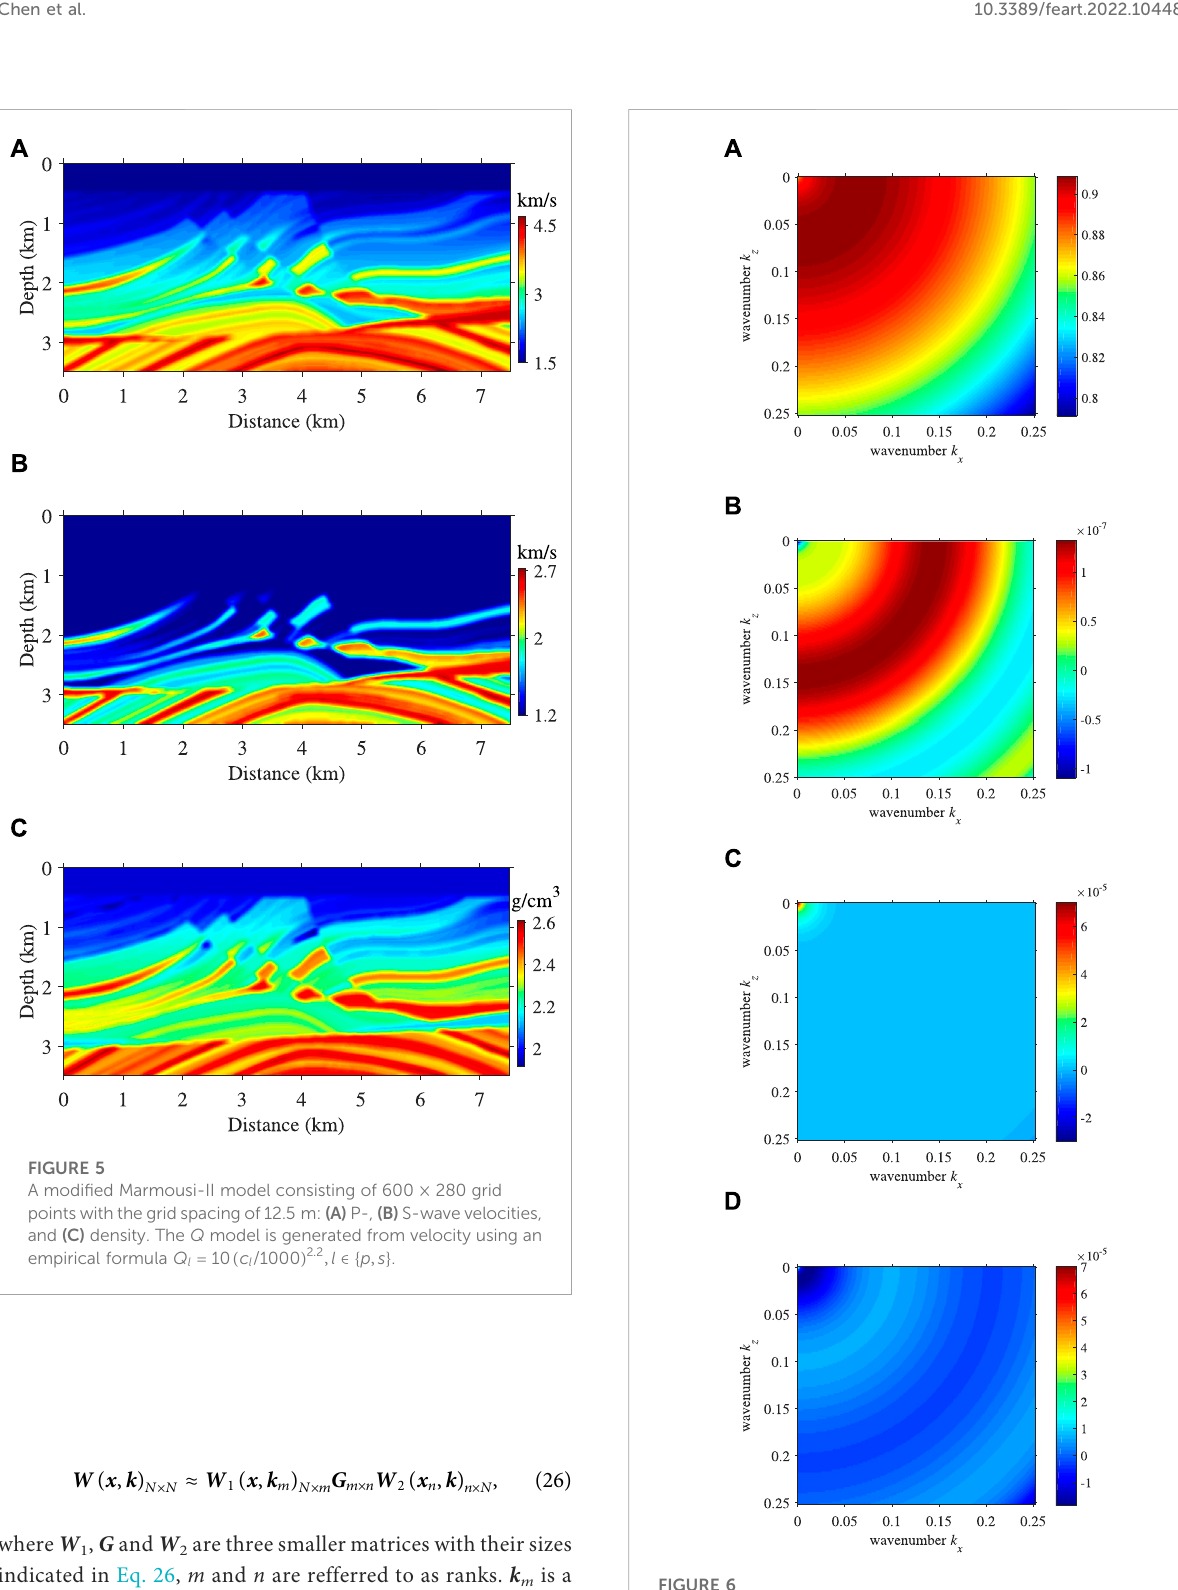
FIGURE 5 A modi fi ed Marmousi-II model consisting of 600 × 280 grid pointswiththegridspacingof12.5 m: (A) P-, (B) S-wavevelocities, and (C) density. The Q model is generated from velocity using an